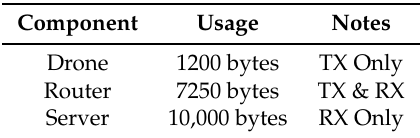
Table 5. Bandwidth usage for Configuration 1.